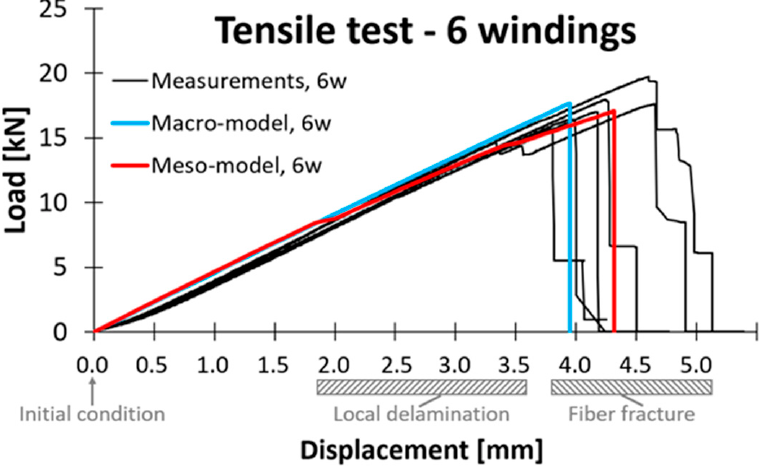
Figure 19. Load-displacement curves from tensile tests on simple loops with six windings (measured and calculated).